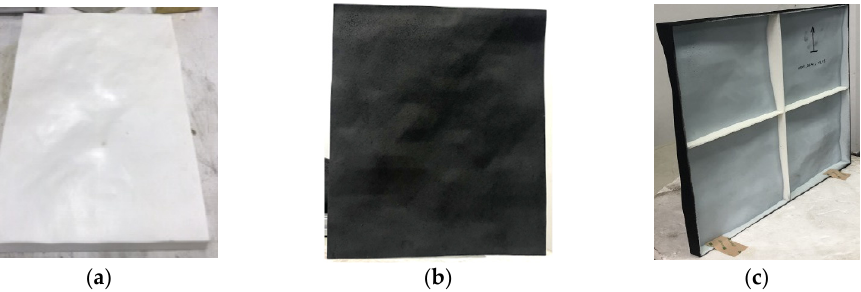
Figure 10. Scaled surface model for measurement. ( a ) Front view before spraying; ( b ) front view after spraying; ( c ) back view after spraying.